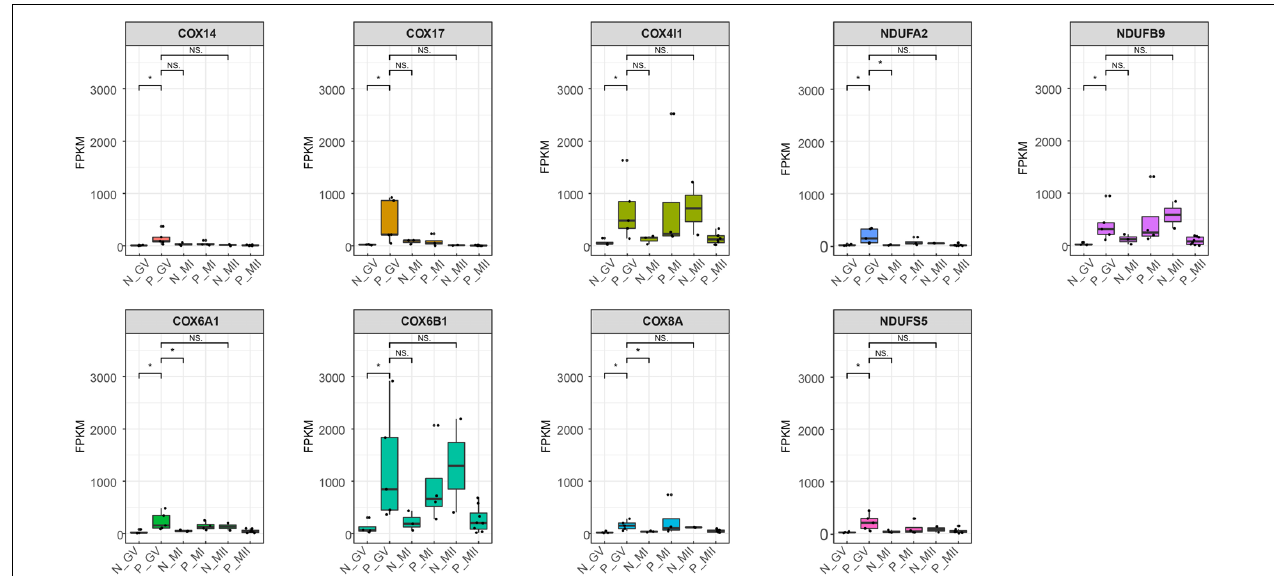
FIGURE 5 | Boxplot shows the dynamics of 9 high differential mitochondria-related genes at different stages between healthy and PCOS oocytes. The FPKM value represent the expression of genes. The line in the box means the media of available samples and p -value < 0.05 was regarded as statistical significance and marked with the asterisk (*). Dots represented the oocytes used in each group. FPKM: fragments per kilobase per million.